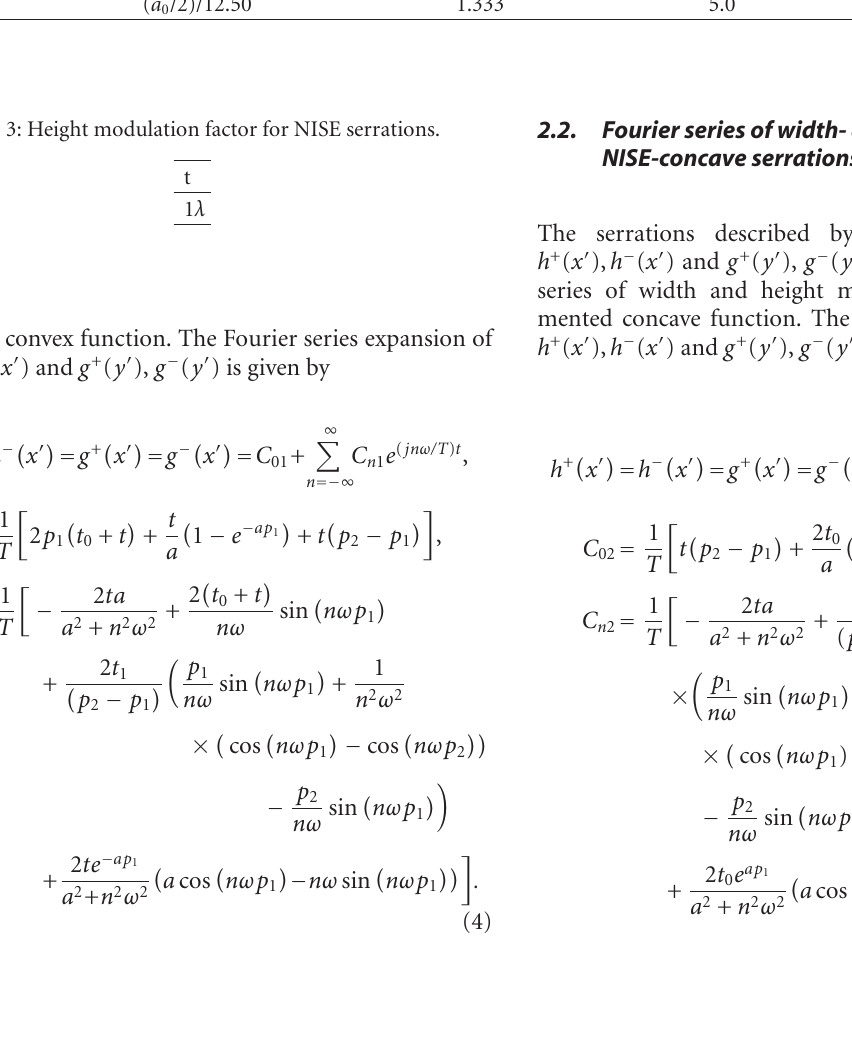
Table 3: Height modulation factor for NISE serrations.